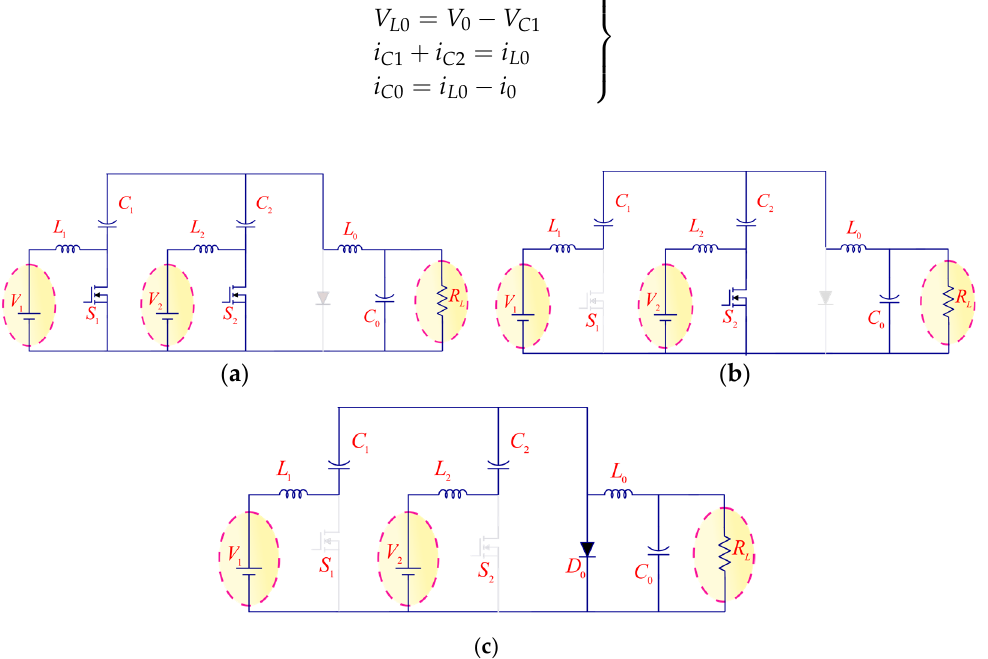
Figure 7. Equivalent circuits: ( a ) State 1, ( b ) State 2, and ( c ) State 3.